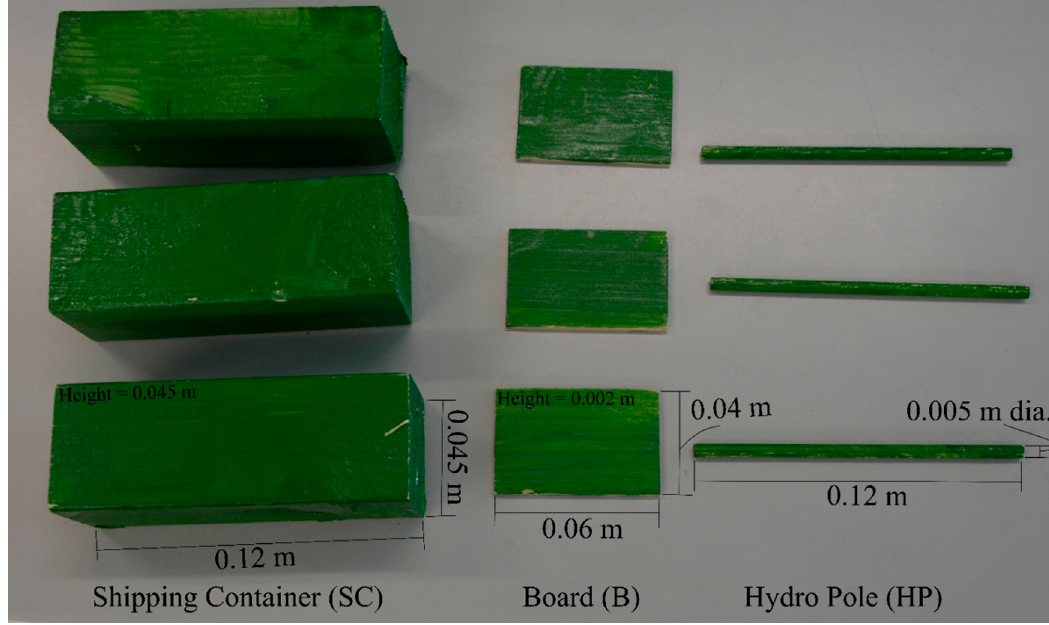
Figure 4. Type of debris: ( a ) Shipping Container (SC); ( b ) Board (B); and ( c ) Hydro Pole (HP).